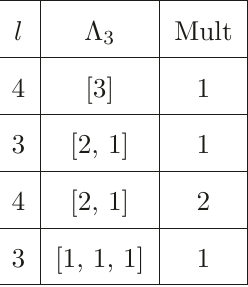
Table 3 . Results for n = 3 fields and k = 4